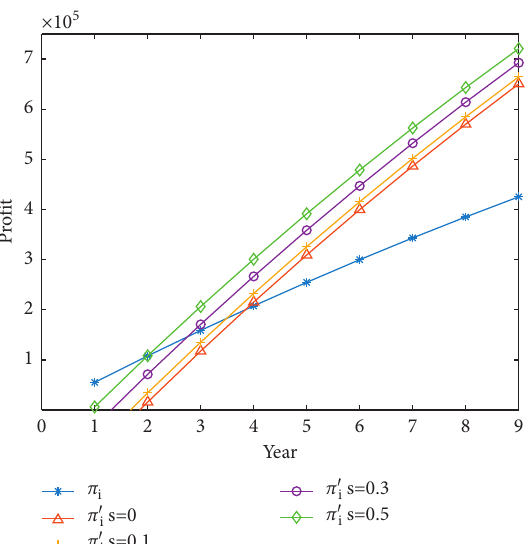
Figure 6: Profits of producers with q